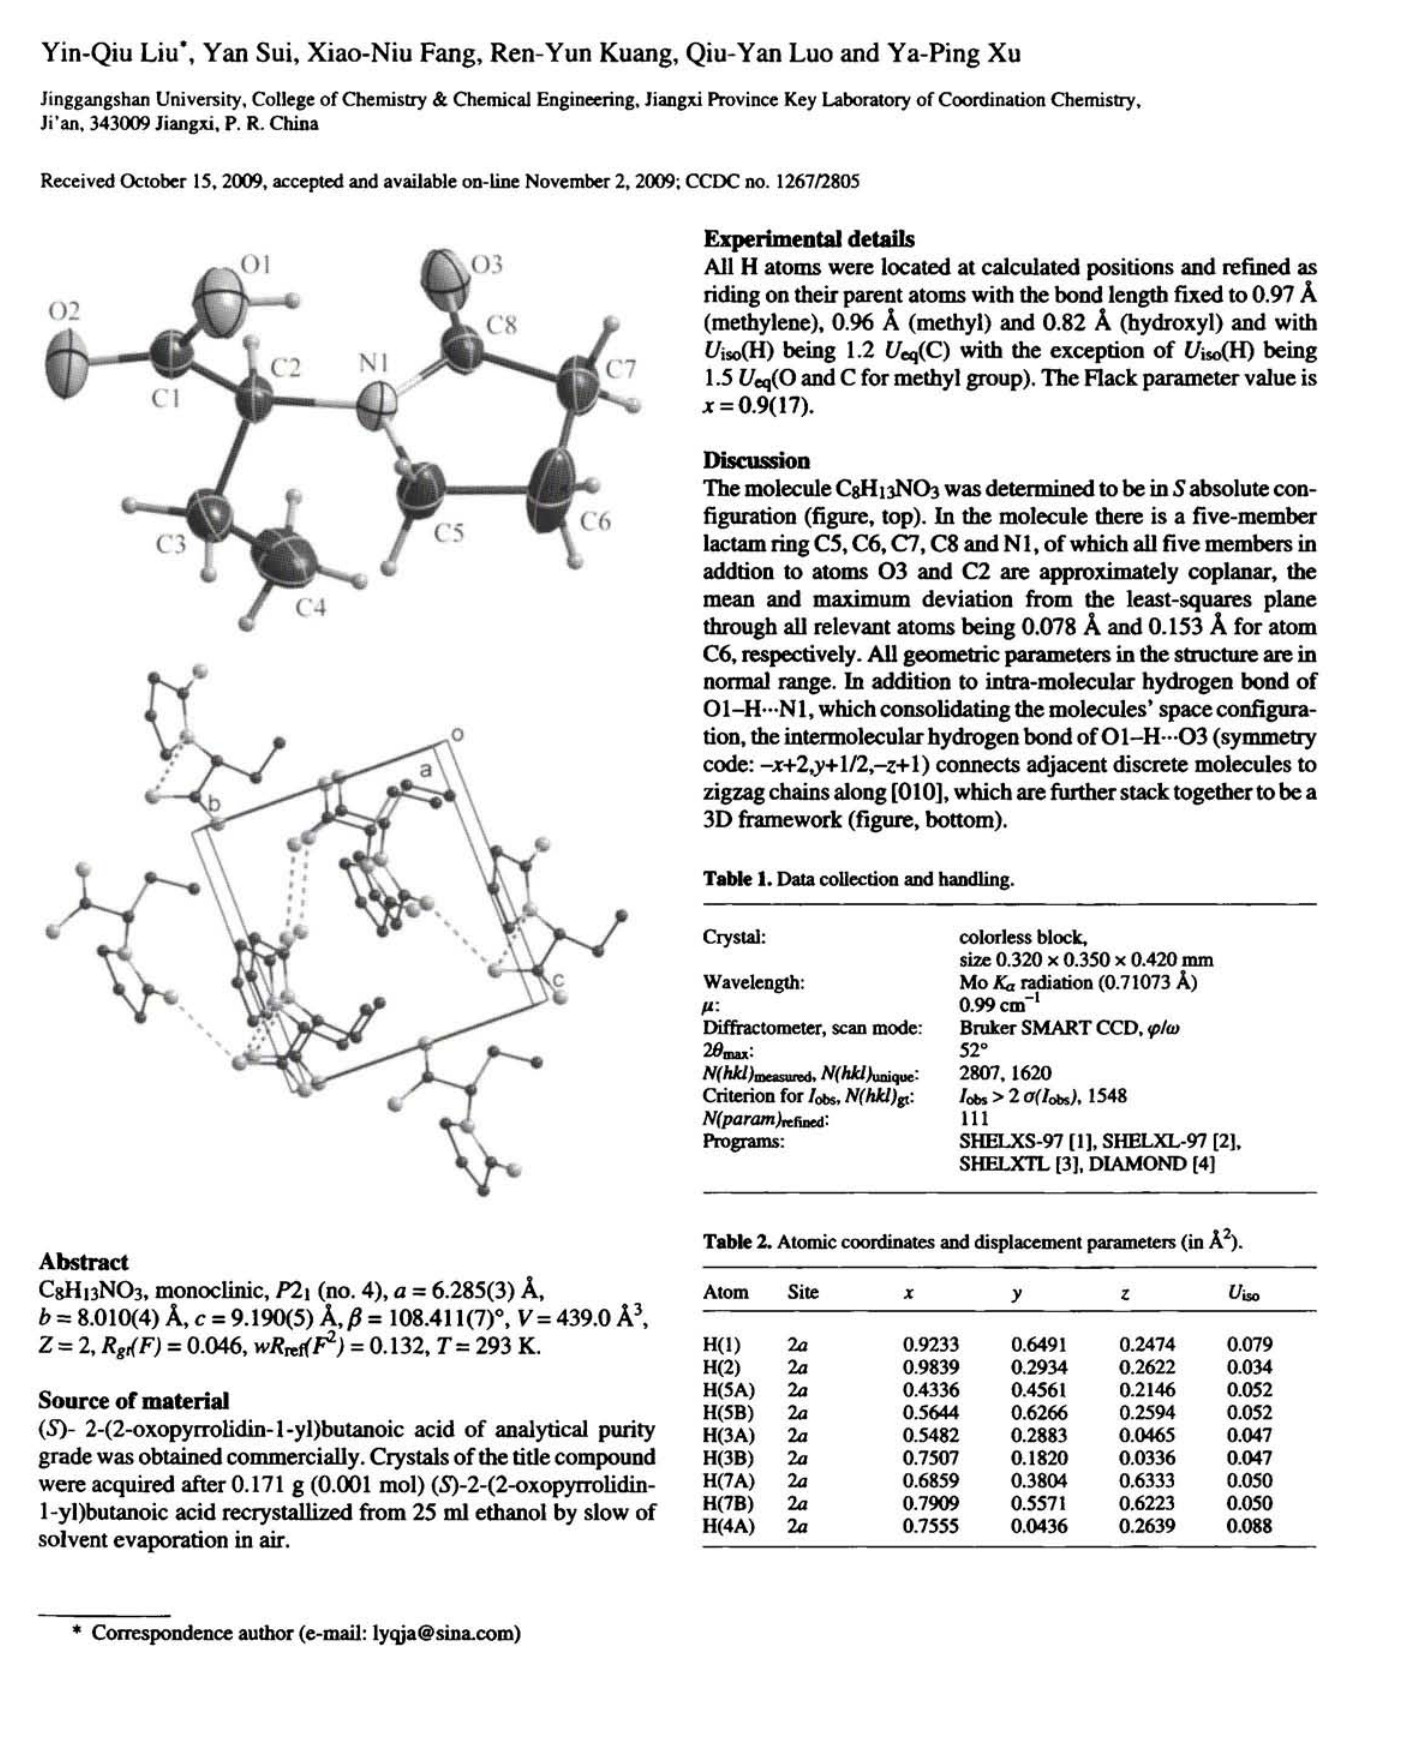
Table 2. Atomic coordinates and displacement parameters (in Â 2